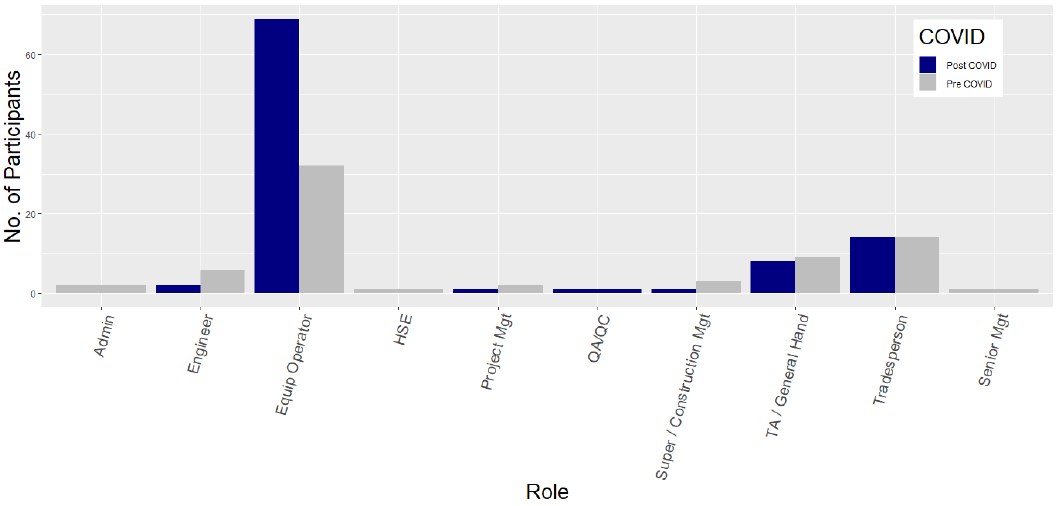
Figure 3. Comparative Participation by Roles.